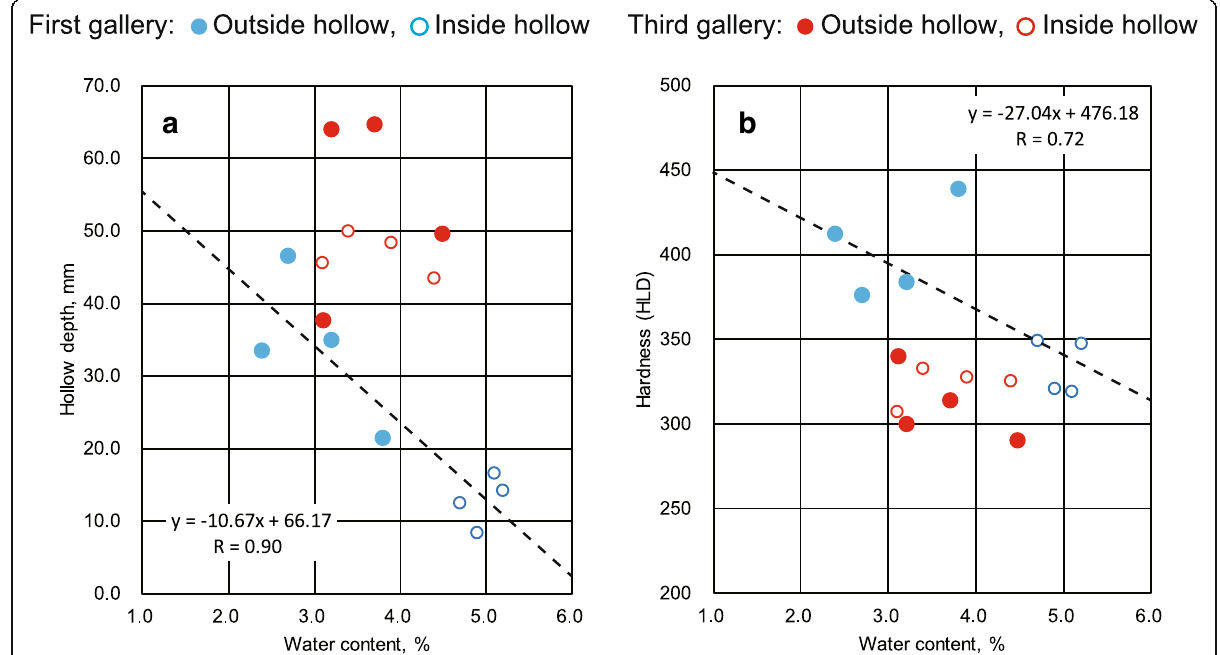
Fig. 8 Relationships between the hollow depth and water content ( a ), and the sandstone hardness and water content ( b ). Dashed lines accompanied with the equation and correlation coefficient (R) indicate regression lines of the first